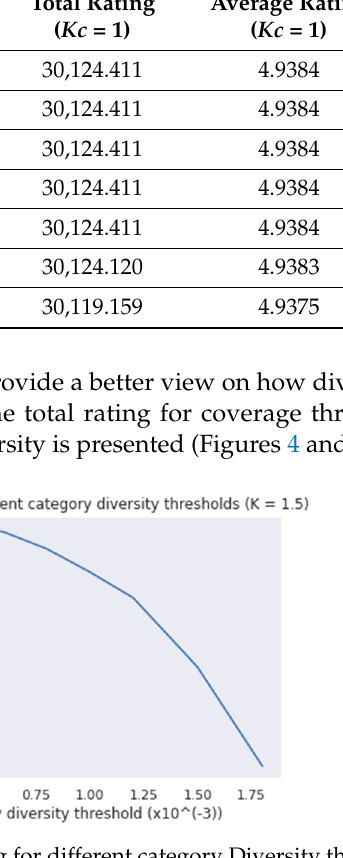
Figure 4. Total rating for different category Diversity thresholds for K = 1.5.